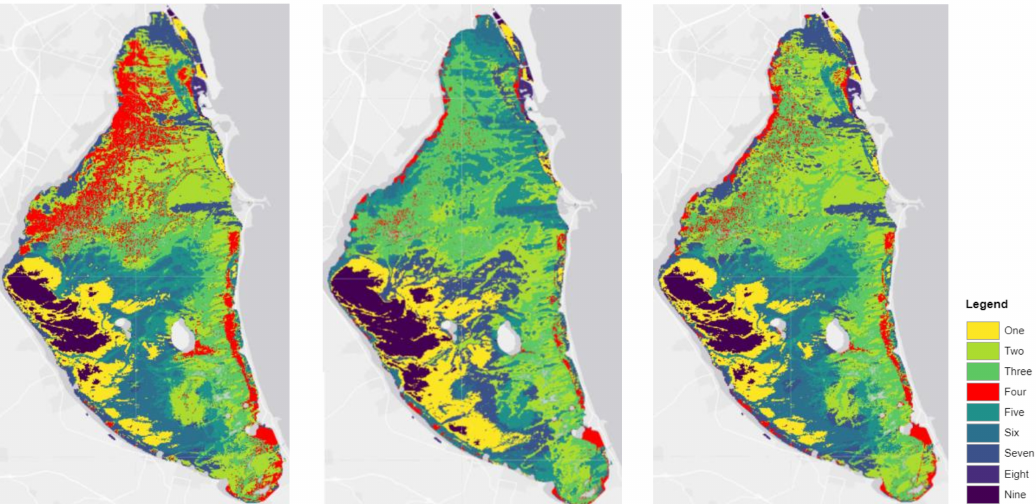
Figure 4. Clustering result in image from 10 May. Nine clusters selected as optimal number. The red cluster represents macroalgae based on in situ expert information. Left panel: all spectral bands, OC3 and NDCI. Central panel: all spectral bands, OC3 and chl_mishra. Right panel: all spectral bands, OC3, chl_mishra, and NDCI (this is the one selected to carry